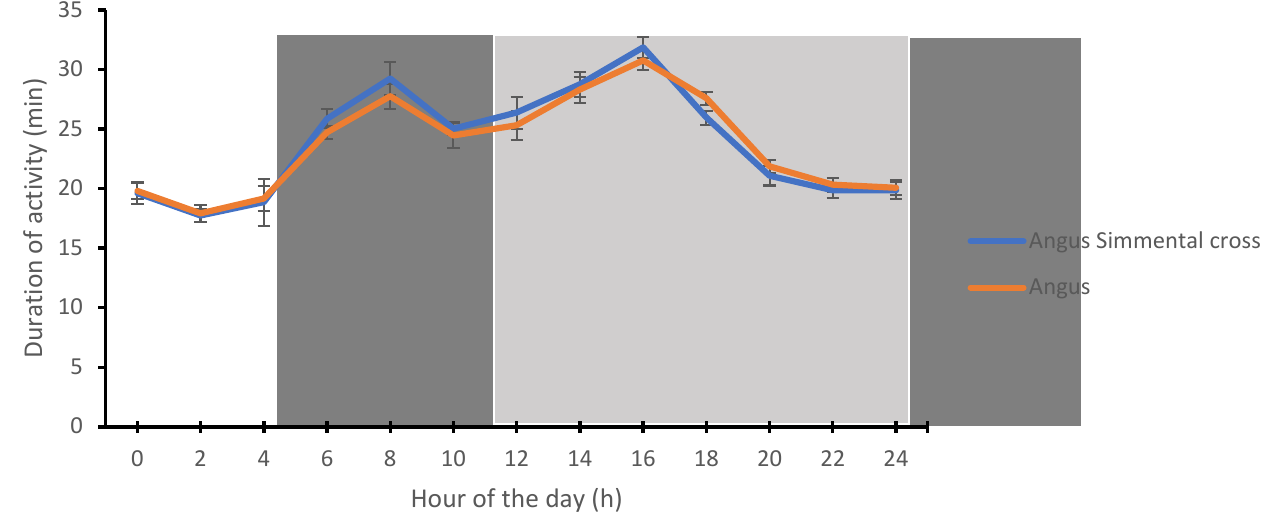
Figure 4. Circadian rhythms of activity in the Angus and Angus-cross. Each datum point represents the mean ± SEM of heifers and steers at each measurement period. The light and dark shades represent the prevailing light–dark cycle.